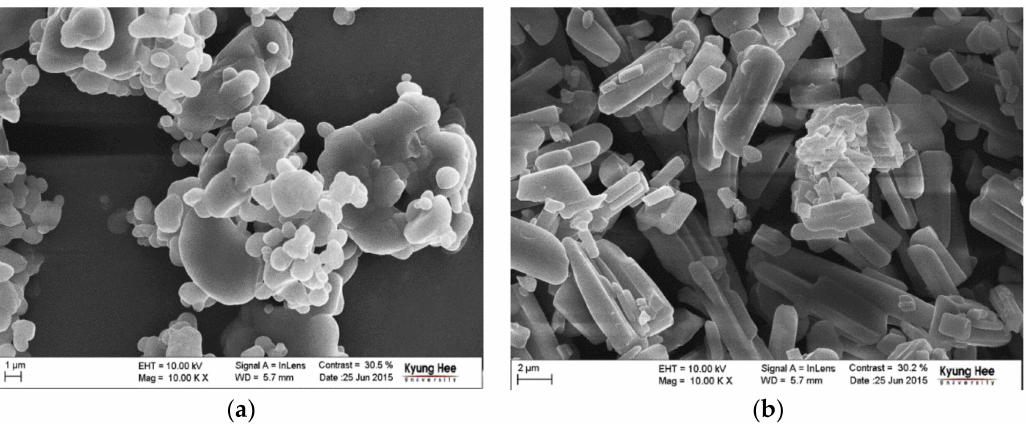
Figure 3. FE-SEM images of CO crystals ( a ) form-I crystals, ( b ) form-II